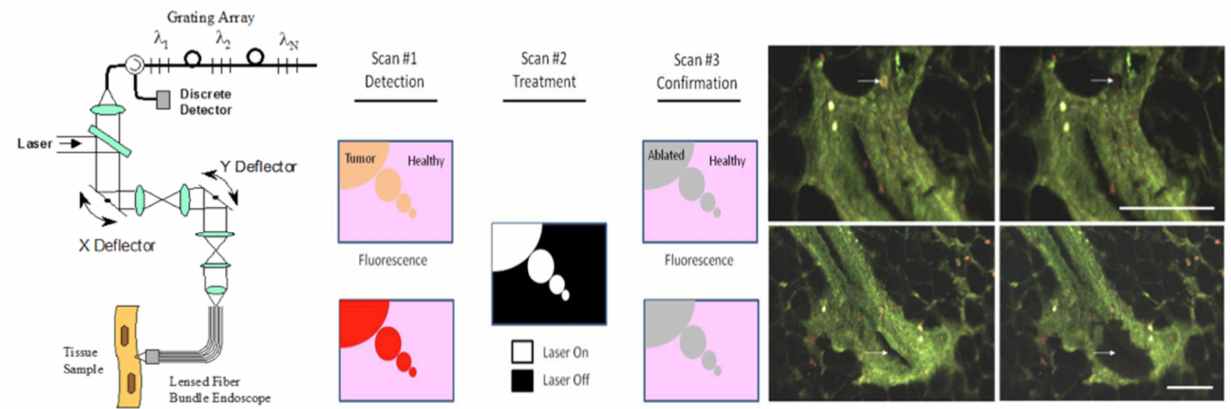
Figure 26. Theranostic high-speed multispectral confocal biomedical imaging and treatment [207–211]. ( Left ): schematics of multispectral scanning confocal system (endoscopy mode). ( Middle ): theranostic intervention by spectral confocal imaging (Scan #1) segmenting the imaged area into healthy and tumor (red); Scan #2 tumor is ablated with pixel precision, by firing the higher-powered laser only over pixels segmented as tumor (with any safety margin chosen). Scan #3 confirms the ablated region. ( Right ): examples of treatment in rat breast cancer model (scale bars = 100 µ m)—arrows indicate where cancer was found (left panels) and ablated (right